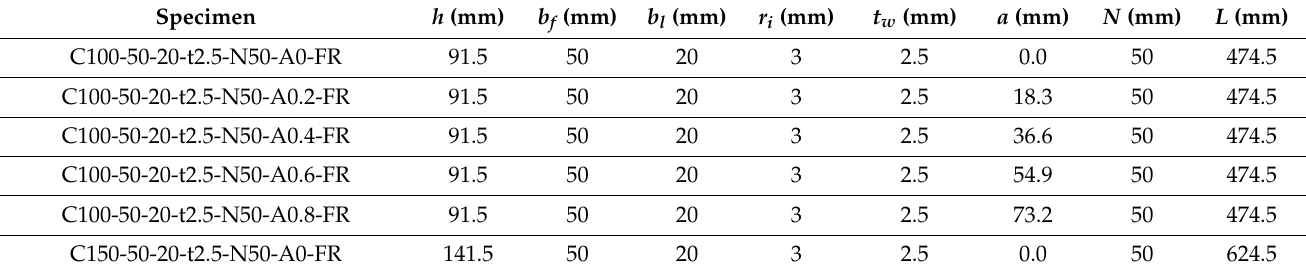
Table 4. Geometric properties of FE models of channel sections with web